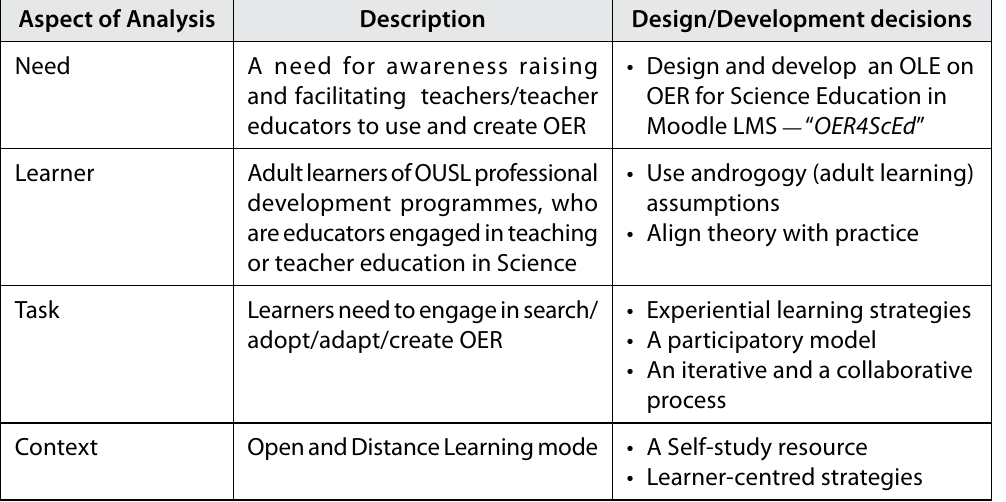
Table 1 Design/Development decisions made during the Analysis